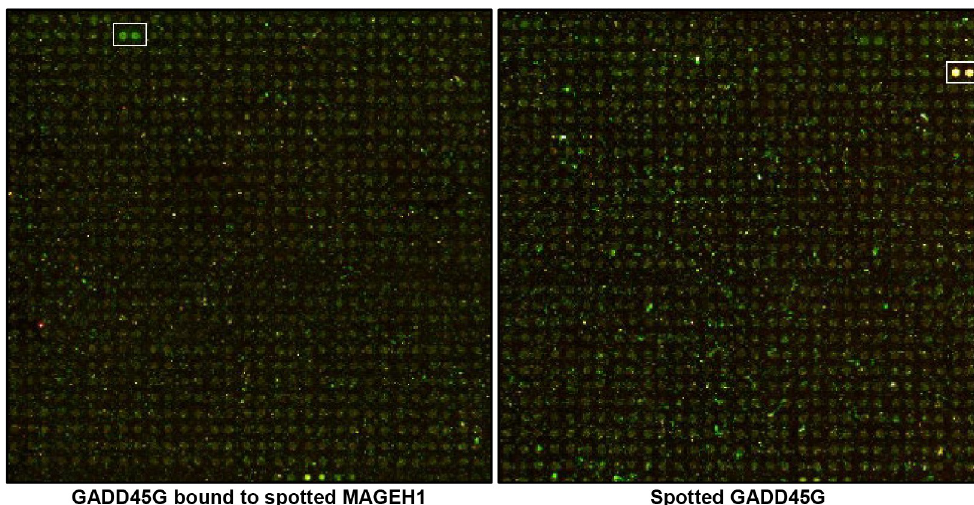
Fig 1. Identification of GADD45G interacting proteins using protein microarrays. The microarray was treated with in the order of an Alexa-Fluor 635 nm (red) conjugated anti-GADD45G antibody, GADD45G protein, and an Alexa-Fluor 532 nm (green) conjugated anti-GADD45G antibody. Therefore, a protein spotted on the microarray that binds to GADD45G protein should be captured by an Alexa-Fluor 532 nm conjugated anti-GADD45G antibody and emits green color. The left panel shows a protein (duplicate) that emits green color which was identified as MAGEH1 (NP_054780). In contrast, GADD45G protein originally spotted in the microarray should be captured by both anti-GADD45G antibodies (Alexa-Fluor 635 nm and Alexa-Fluor 532 nm) and emits yellow color that combines red and green color (right panel).